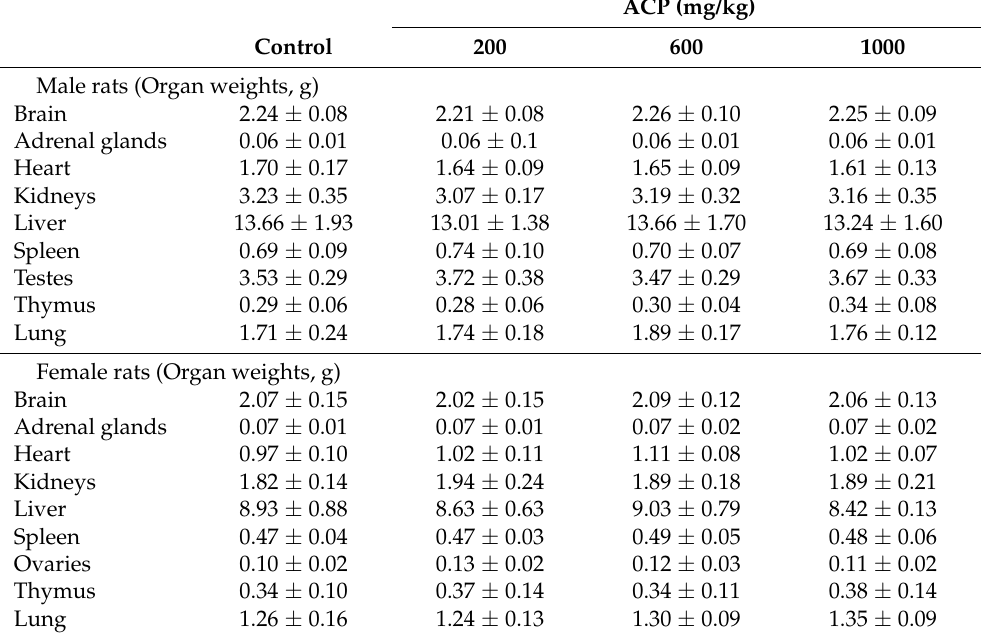
Table 2. Absolute organ weights of male and female rats treated with or without ACP for 90